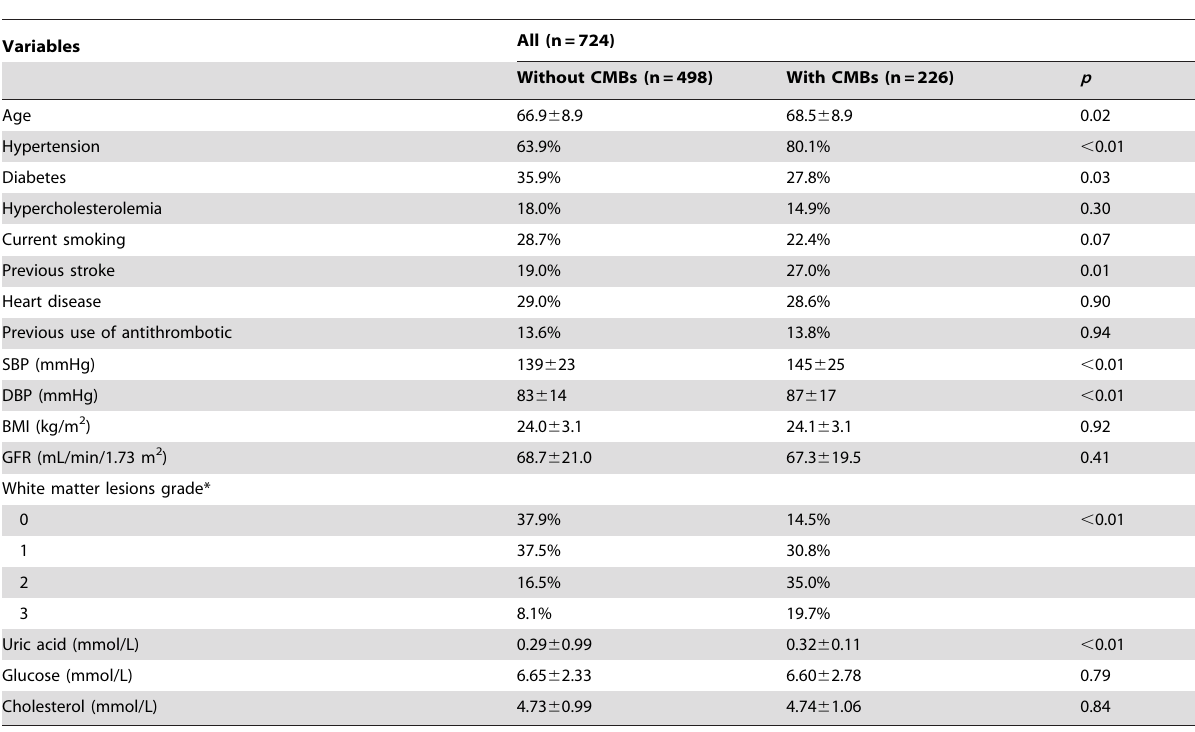
Table 1. Baseline Characteristics of Patients According to Presence or Absence of